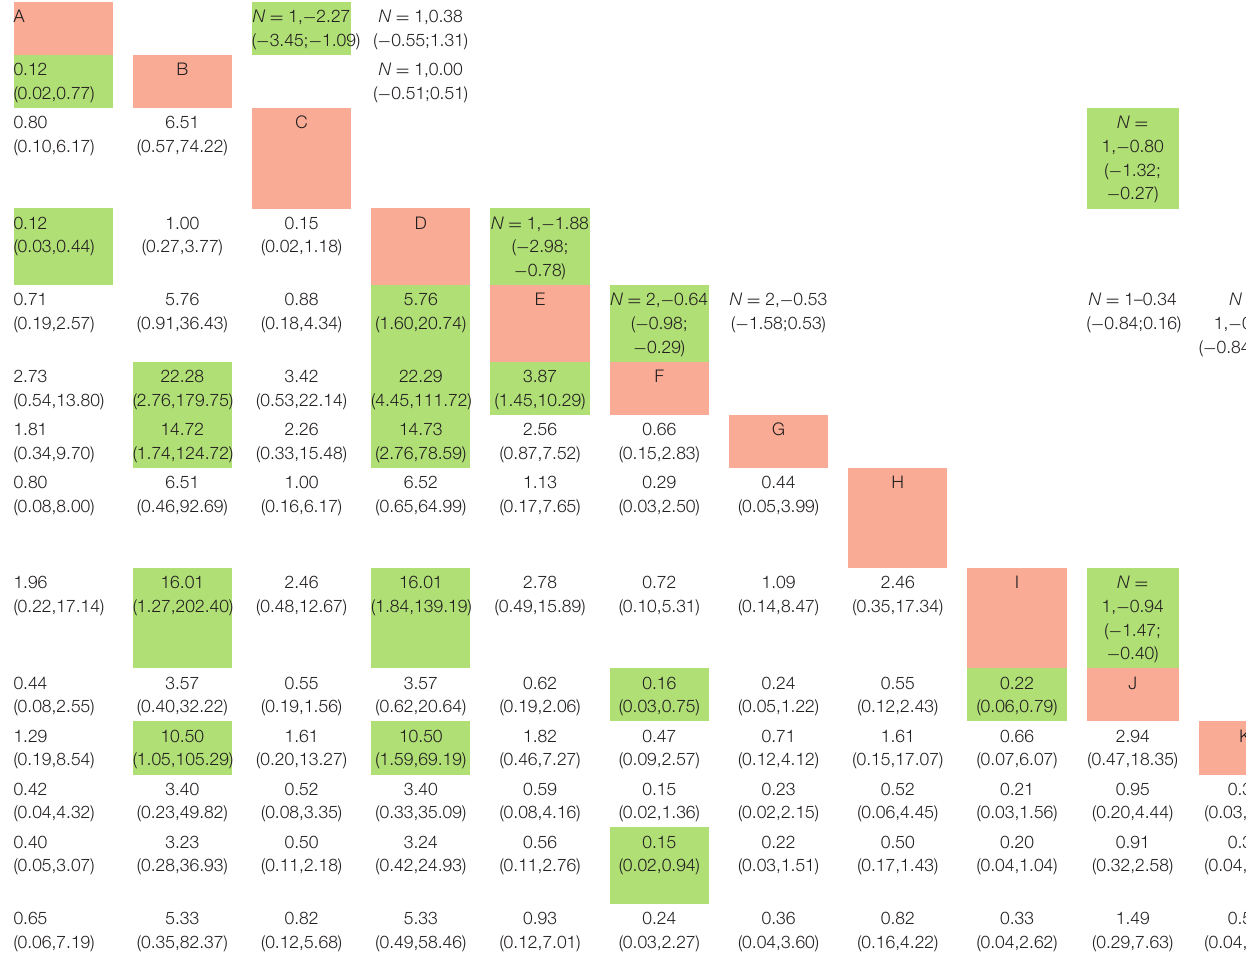
TABLE 7 | Results of treatment comparisons for postoperative 48h.